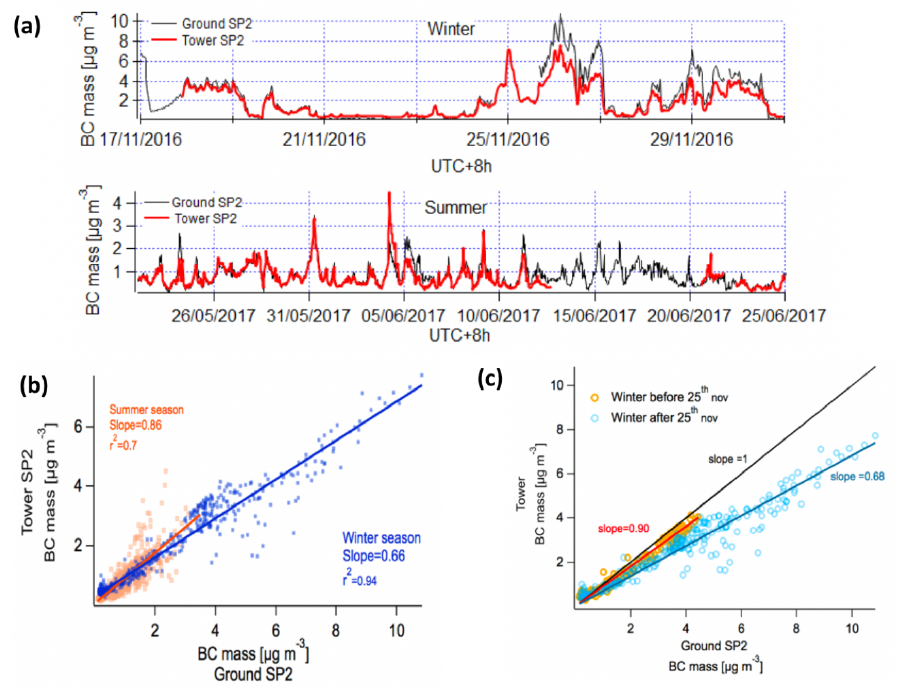
Figure 4. (a) Comparisons of BC concentrations at 5m (black) and 102m (red) in winter and summer. (b) Correlation of BC concentrations measured at the two different levels for winter (blue) and summer (orange). (c) Correlation of BC mass concentrations before and after 25 November.